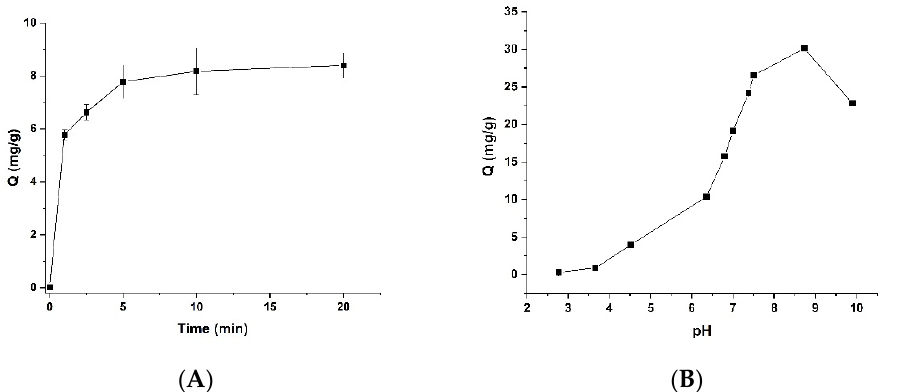
Figure 5. ( A ) Lysozyme binding on Lys-PMNPs after increasing incubation times. (Lys-PMNP concentration is 1.6 mg/mL; lysozyme concentration is 25 µg/mL in 50 mM PB, pH = 7; (n = 3)); ( B ) effect of pH on the lysozyme binding capacity of Lys-PMNPs. (1.6 mg/mL Lys-PMNP was incubated with 50 µg/mL lysozyme in different buffers. Citrate-phosphate buffers were used between pH 2.8 and 7.4 and carbonate-bicarbonate buffers at pH 8.4 and 9.7. The buffer concentration was 10 mM in each case. The pH of the buffered lysozyme solution was measured and plotted on the x -axis. (n = 3)).